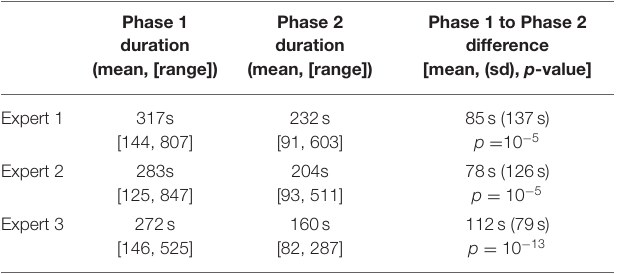
TABLE 7 | Statistics on time elapsed for each of two phases for the three expert and comparison between the two phases.